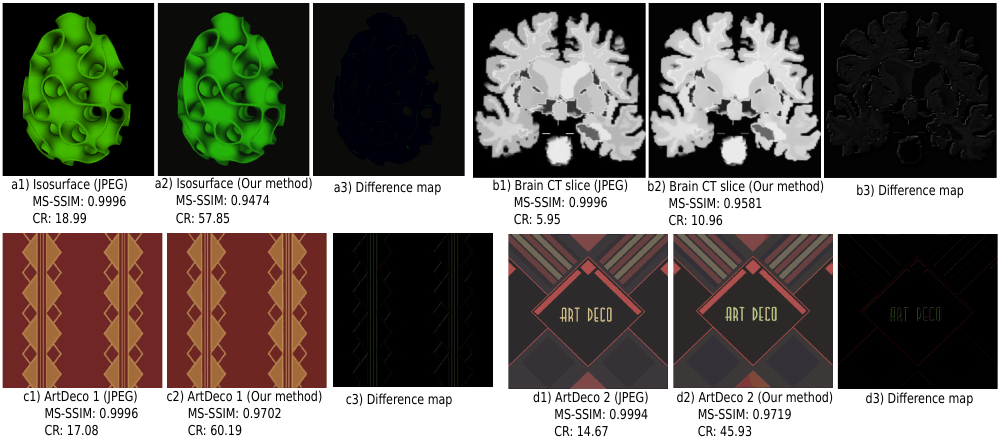
Figure 10. Our method ( a2 – d2 ) yields higher compression than, and visually identical quality with, JPEG ( a1 – d1 ) for two image classes: Scientific Visualization ( a , b ) and Art Deco ( c , d )).